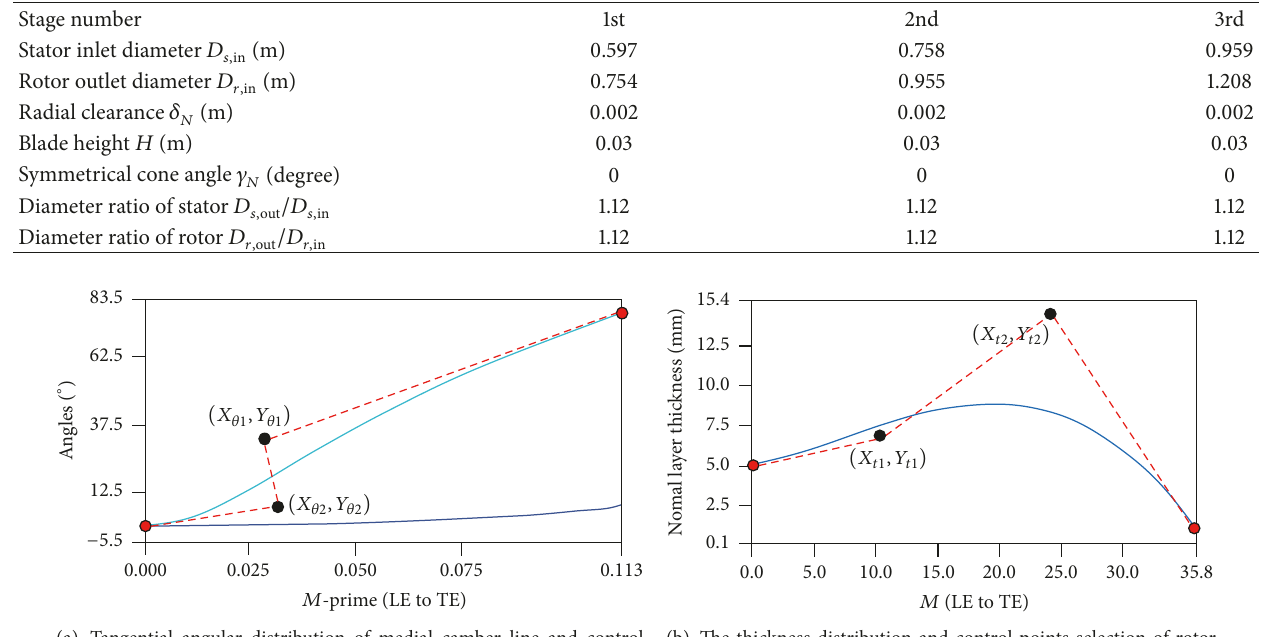
Table 4: The main geometrical parameters of the centrifugal turbine.